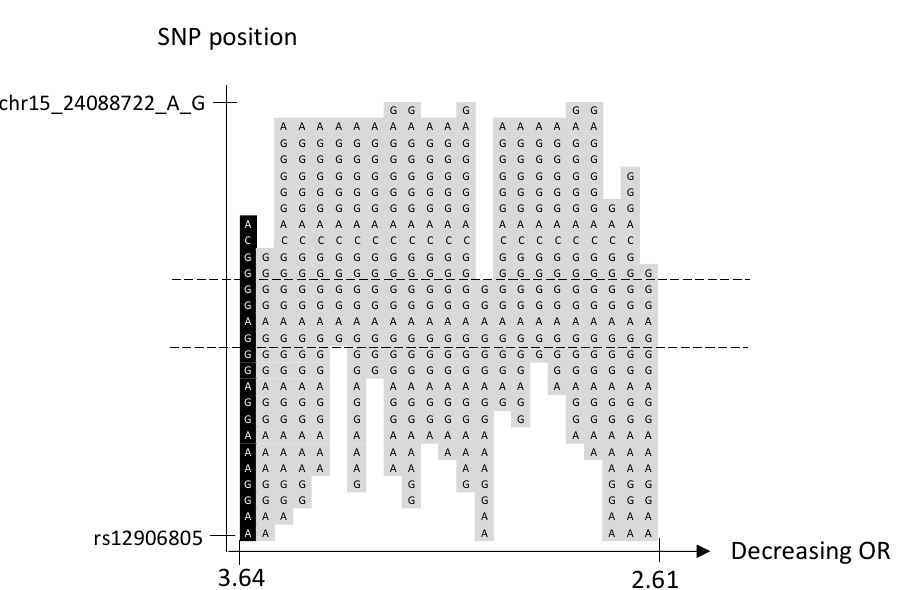
Figure 3. Chromosome 15, one significant and 22 borderline significant haplotypes sorted by OR. The significant haplotype is marked in black and borderline significant in light gray. SNP position is on the y -axis. The corresponding OR is on the x -axis. The dashed lines indicate the proximal and distal SNP that are shared by the significant and borderline significant haplotypes.